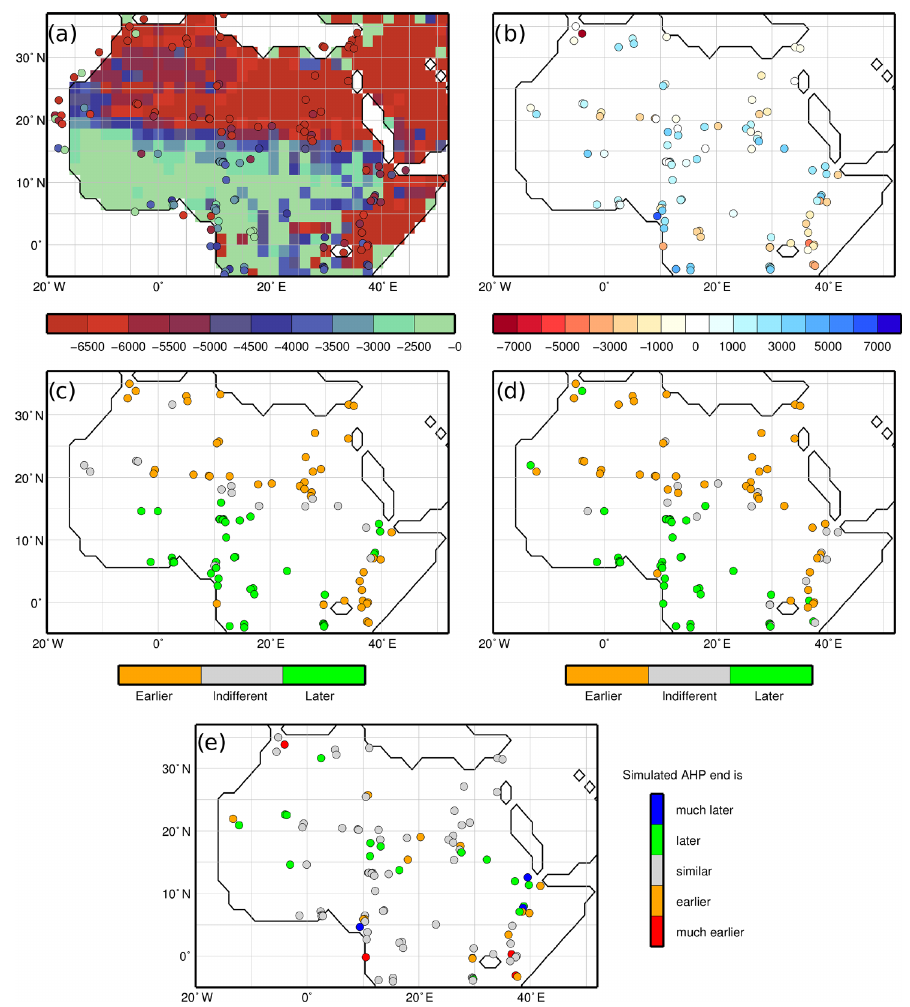
Figure 4. (a) Simulated end of the AHP at each individual grid cell (shaded) and reconstructed end by Shanahan et al. (2015). (b) Absolute difference (years) between the AHP end in the model and in the reconstructions. (c–e) Comparison of the relative timing of the AHP end in the model and the reconstructions. For this, the simulated end times have been assigned to 500-year intervals being comparable to the temporal resolution of the records. (c) For each grid cell in the model in which a record site is located, it was calculated if the simulated AHP end was earlier than (orange), later than (green), or similar (grey) as to that of most other grid cells in which sites are located. (d) Same as (c) but for the records (e) difference of the relative timing (model minus records), e.g. “much earlier” (red) indicates sites at which the relative time based on the model results was classified at a much earlier point in time than based on the records. Please notice that for the comparison only terrestrial sites have been